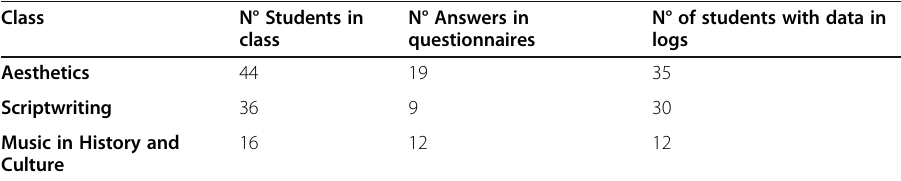
Table 2 Summary of data